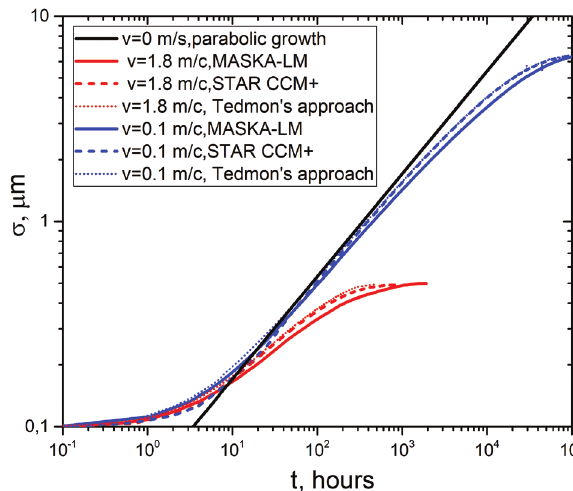
Figure 13. Distribution of oxygen dissolved in HLMC in the cross section of the pipe at Т = 500 °С.